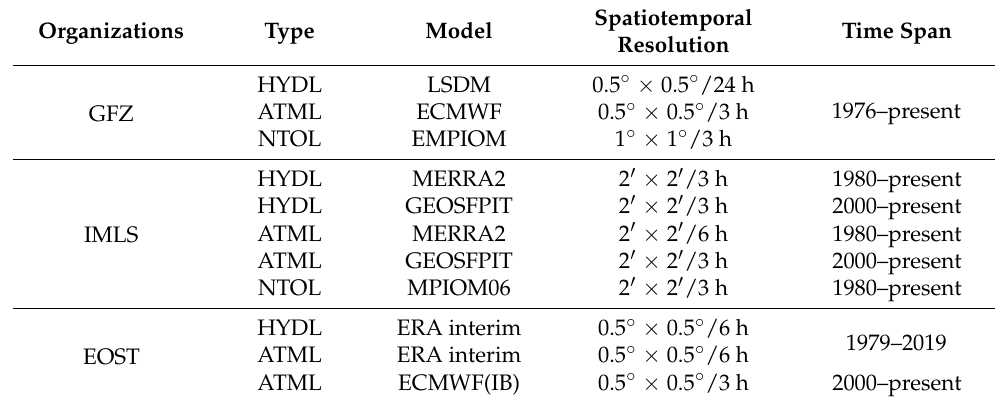
Table 1. Environmental loading product provided by GFZ, IMLS, and EOST.